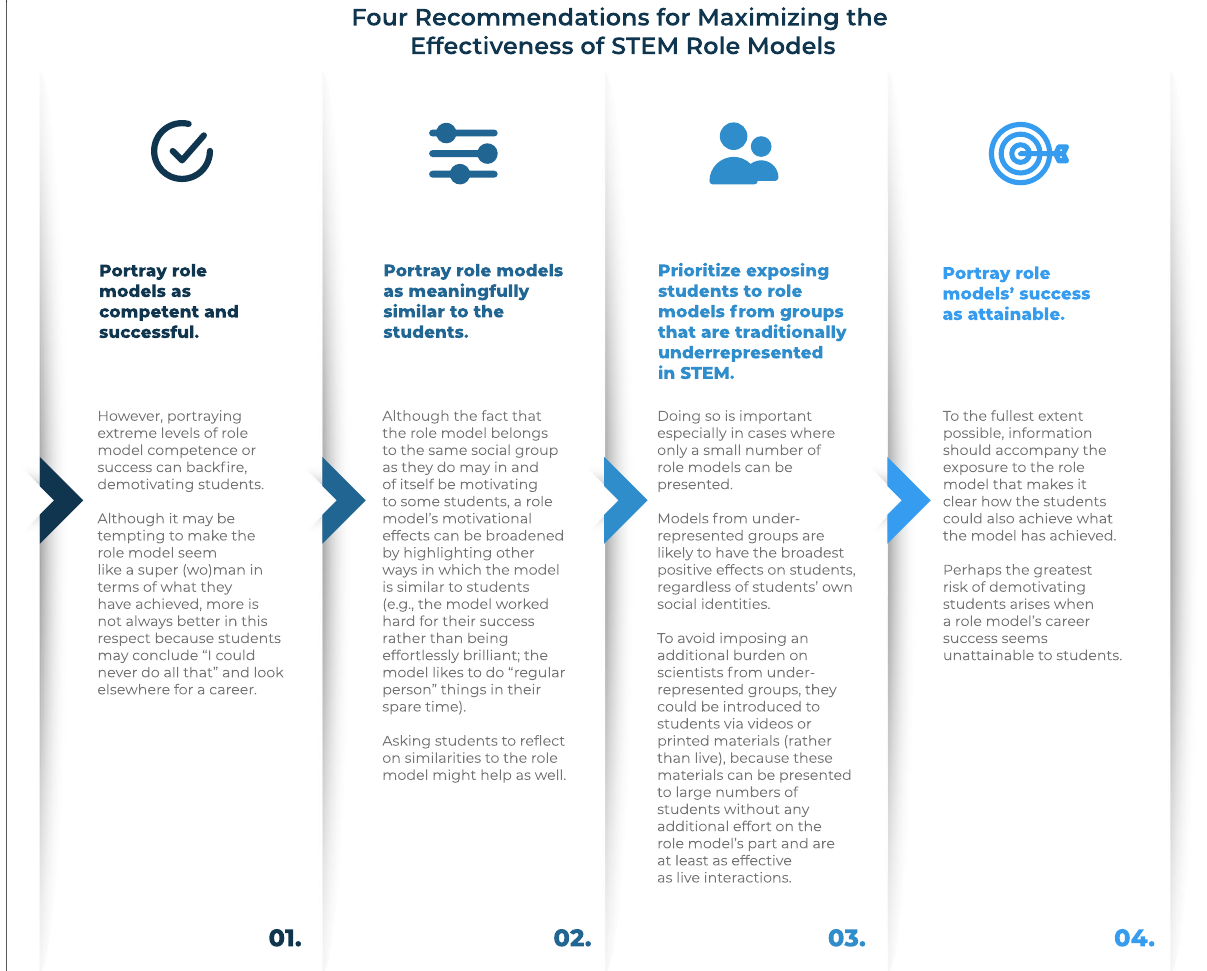
Fig. 2 Four recommendations to consider when exposing students to role models as a means of boosting their STEM motivation. High-resolution versions of this infographic in .eps, .jpg, .pdf, and .png formats are freely available at https:// doi. org/ 10. 6084/ m9. figsh are.c. 56816 74.